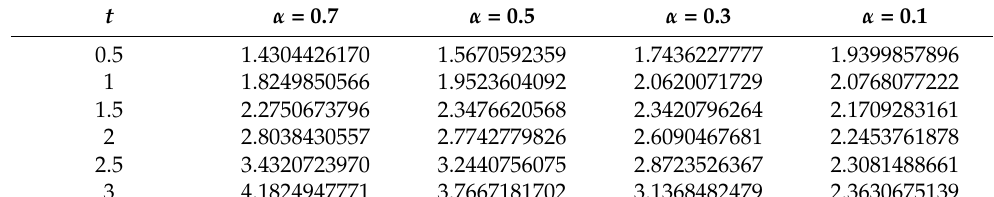
Table 3. Numerical solutions of the 12th FSS for the nonlinear time-FBPM (15).